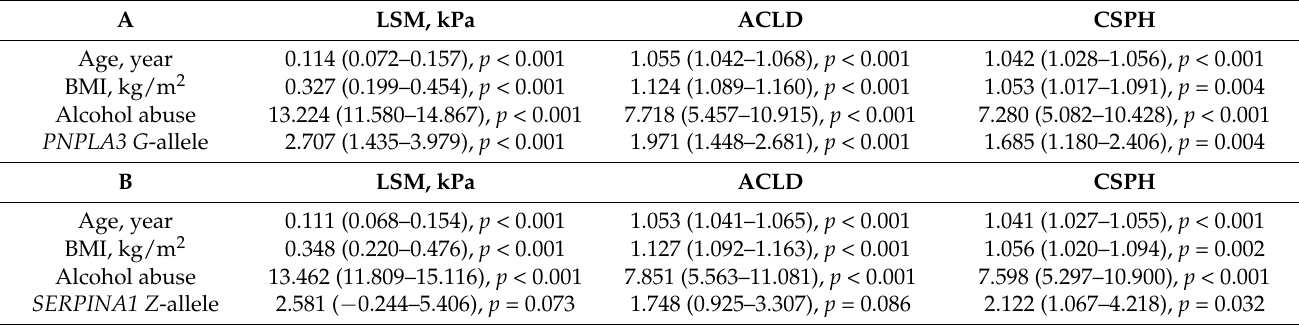
Table 2. Multivariable linear and logistic regression analyses investigating the association of individual risk alleles with the liver stiffness measurement (LSM), the presence of advanced chronic liver disease (ACLD) and clinically significant portal hypertension (CSPH): ( A ) for the PNPLA3 G -allele and its covariables, ( B ) for the SERPINA1 Z -allele and it covariables and ( C ) in a combined multivariable regression model for both the PNPLA3 G -allele and SERPINA1 Z -allele. ( D ) Multivariable logistic regression model comparing patients with no risk allele (reference) to those with one or two risk alleles. Covariables were: age (per year), BMI (per kg/m 2 ) and active or past alcohol abuse ( ≥ 2 drinks per day for women, and ≥ 3 drinks per day for